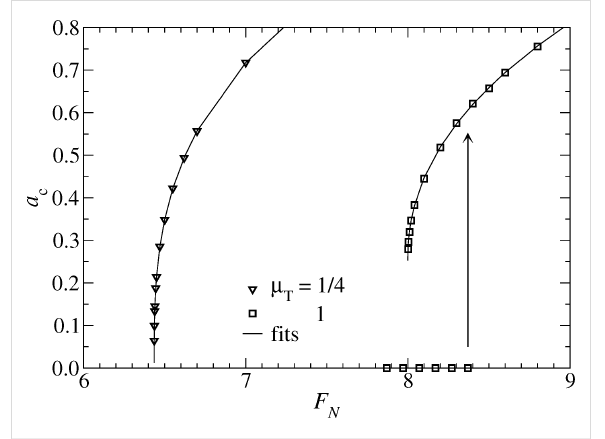
Figure 17: Contact radius a c as a function of normal force F N in the vicinity of the spontaneous wetting force F sw . Symbols reflect numeri- cal results while lines are fits according to Equation 54. They termi- nate at a c ( F sw ). In the case of μ T = 1, an arrow indicates where the a c = 0 solution becomes unstable with increasing F N